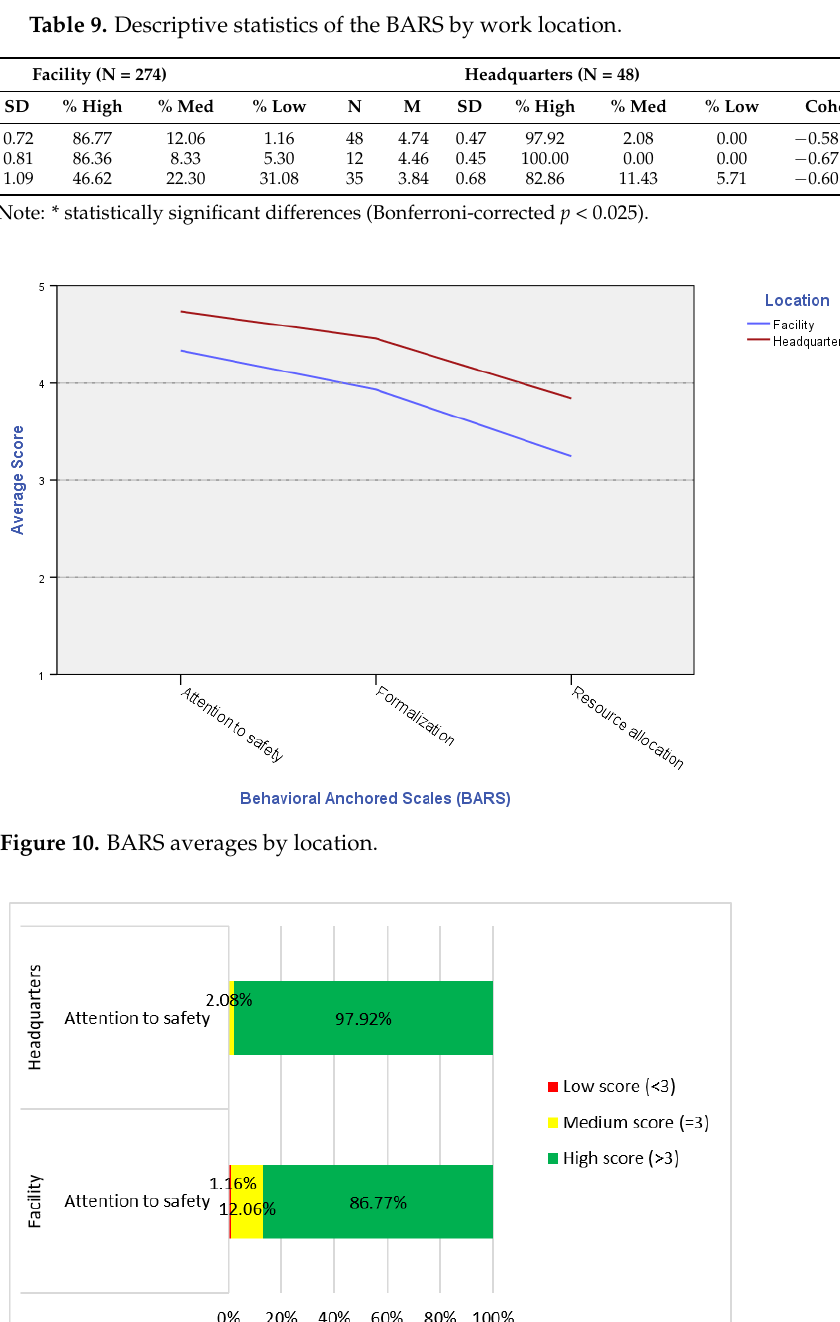
Figure 12. Categorized BARS percentages for formalization, by location.